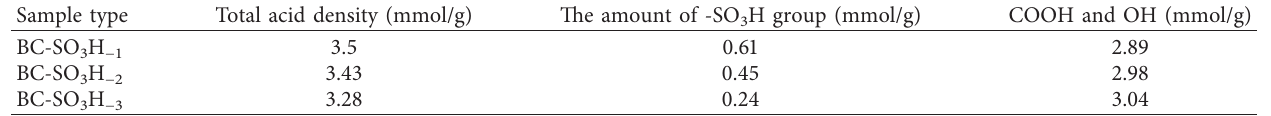
3 H, COOH, and OH groups of catalyst.